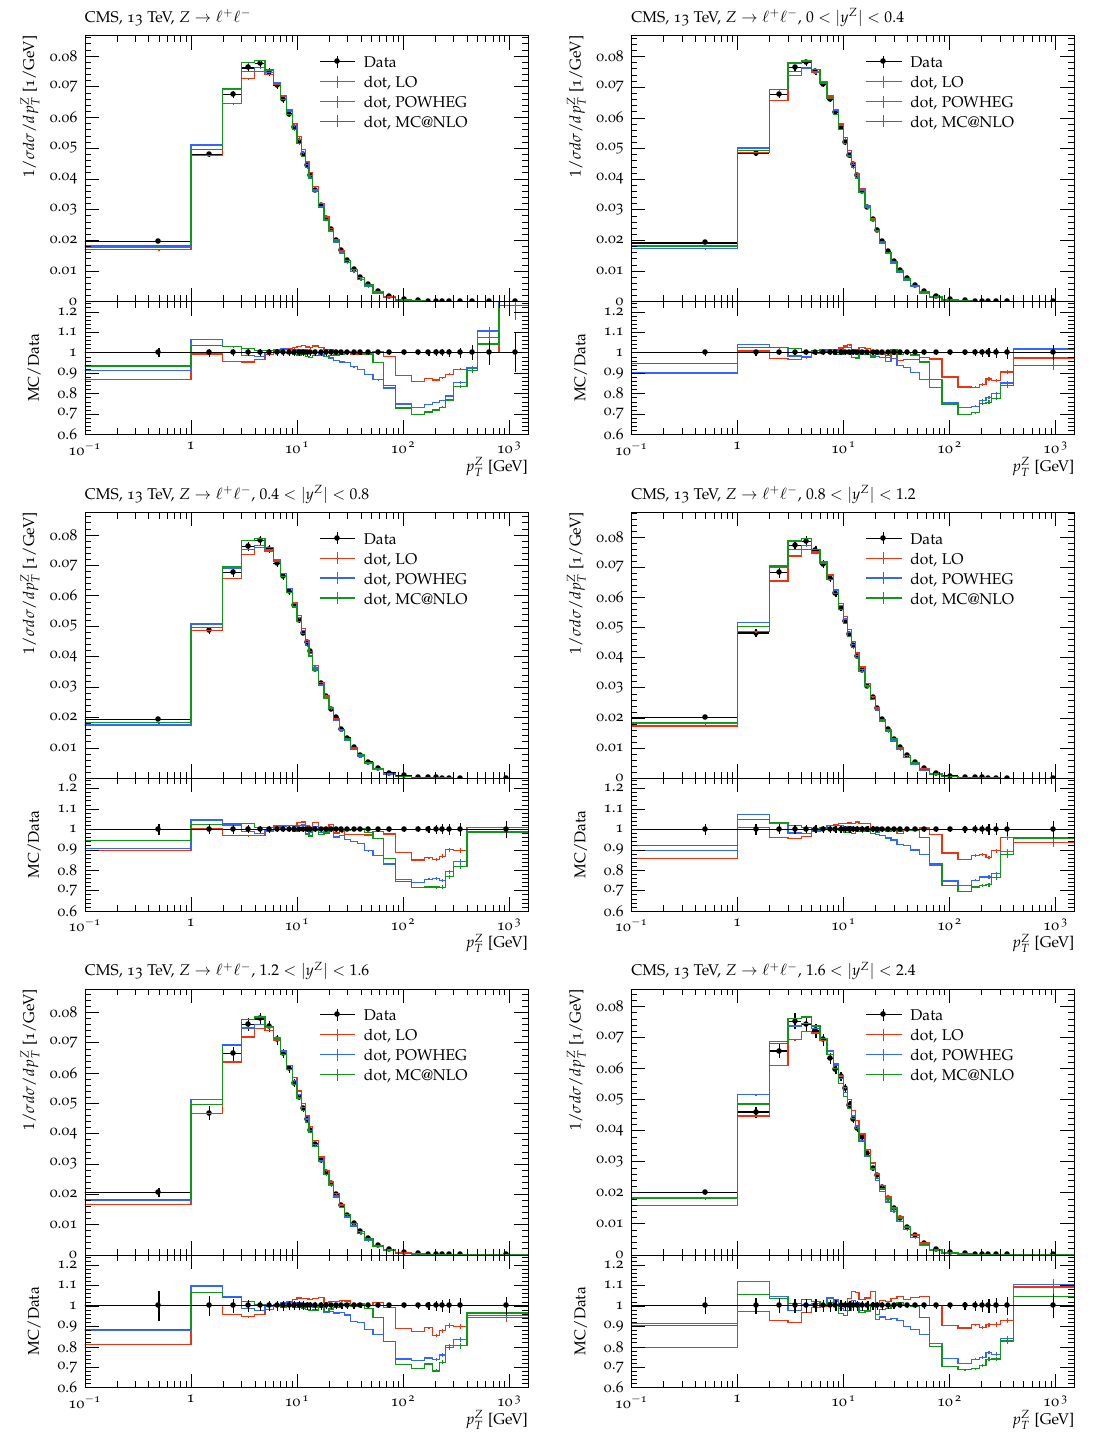
Figure 7 . Differential normalized cross section as a function of Z p ⊥ , broken down into different rapidity ranges. Herwig results are compared to CMS [20] data at 13